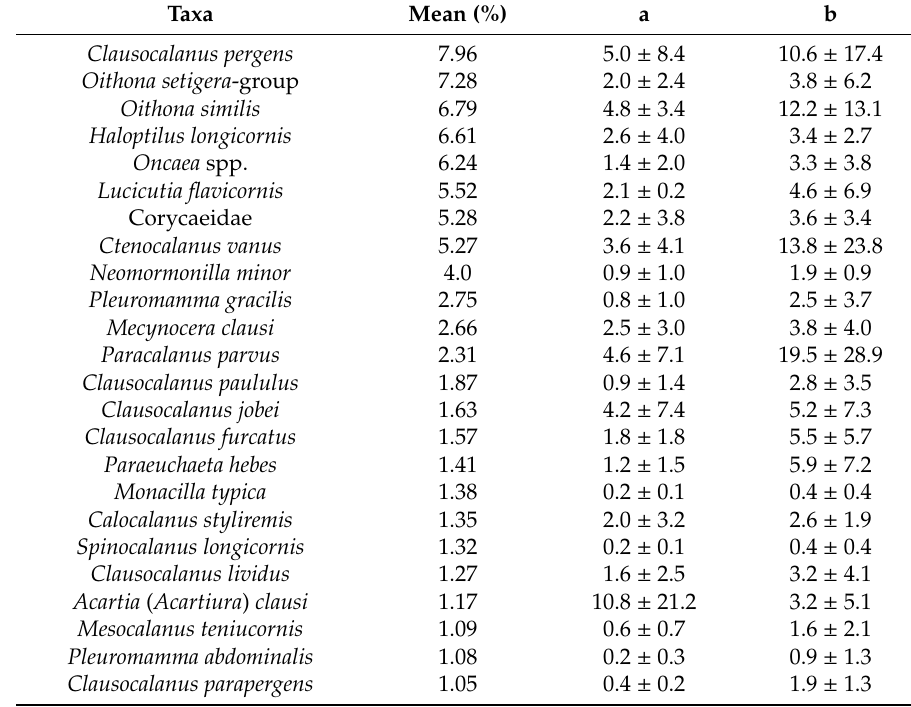
Table 2. The most abundant copepod taxa ( > 1% contribution): Mean percentage in total numbers and mean abundance (ind. m − 3 ± SD) in December (a) and April